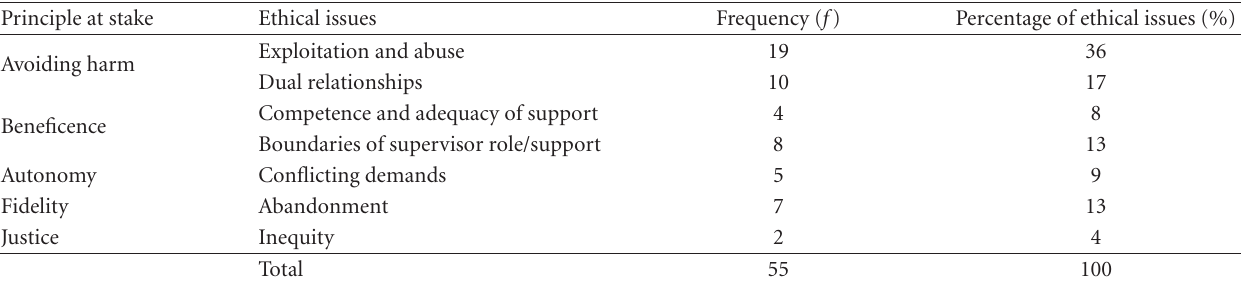
Table 1: Ethical principles, related issues, and frequency in the